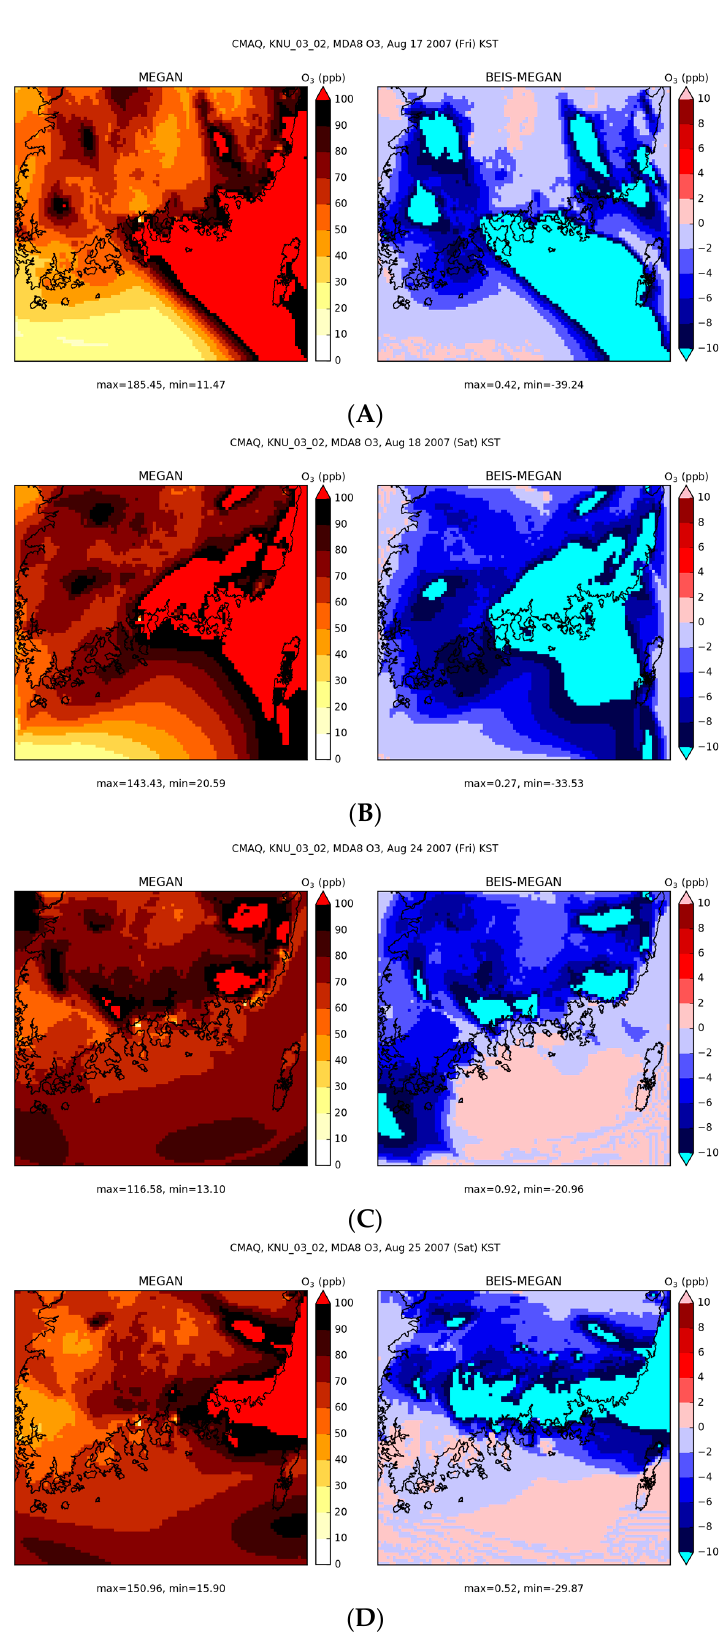
Figure 9. One-hour ozone concentrations estimated with CMAQ-MEGAN ( left ) and differences between CMAQ-MEGAN and CMAQ-BEIS3 ( right ) in 2007: ( A ) 5 PM on 17 August; ( B ) 3 PM on 18 August; ( C ) 4 PM on 24 August; and ( D ) 3 PM on 25 August.